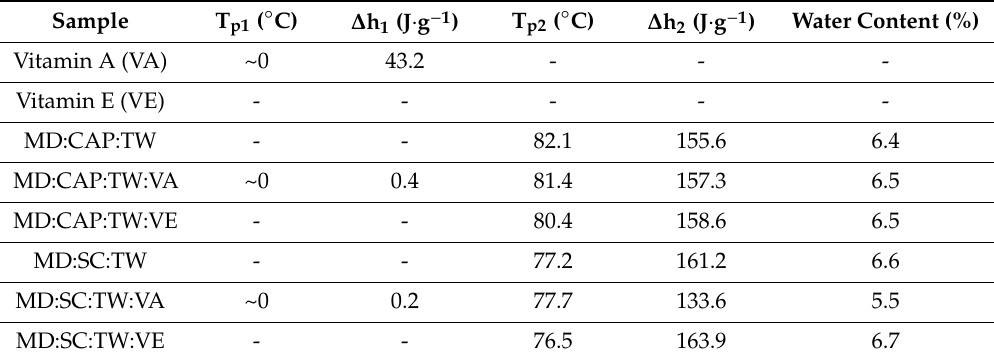
Figure 3. First heating di ff erential scanning calorimetry (DSC) thermograms of ( a ) vitamin A (VA) and vitamin E (VE); ( b ) MD, CAP, SC, and TW components and comparison between encapsulated vitamins and Table 3. Peak temperature (T p ) and enthalpy values ( ∆ h) of the main endothermic events in the first heating